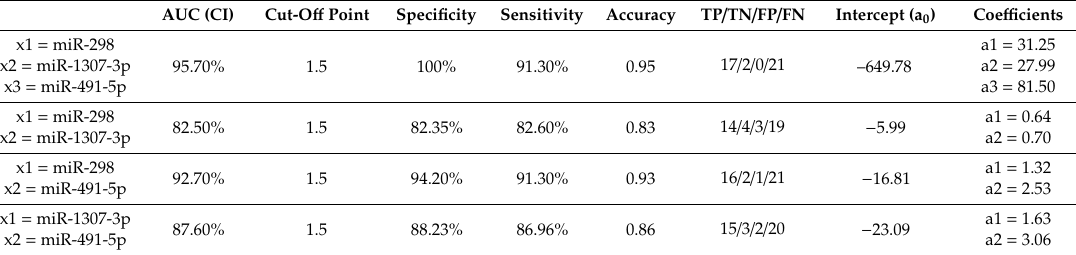
Table 3. Summary of the basic parameters and common quality measures of the models. AUC (CI) Cut-O ff